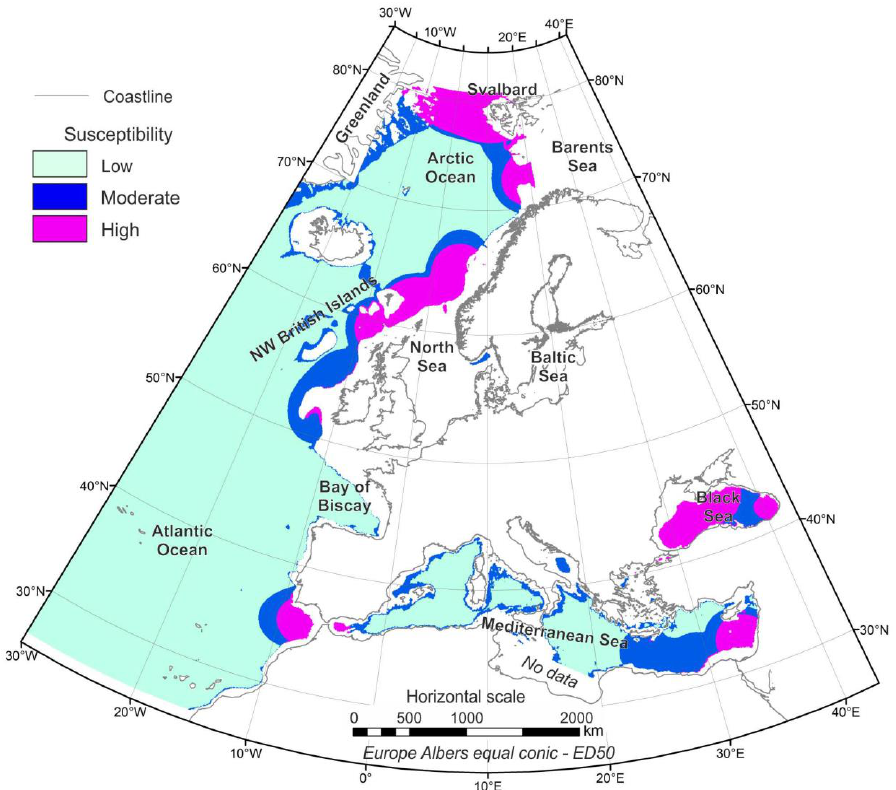
Figure 5. Susceptibility assessment of the seafloor to the presence of hydrates on the European continental margins and adjacent areas. Susceptibility values were segmented into three levels by quantiles: low from 0.009 to 0.0129, middle from 0.0129 to 0.0325 and high from 0.0325 to 1.009. The susceptibility assessment shows seven areas with high values: Svalbard, the northern Norwegian mar- gin ─ Barents Sea, the continental slope of the mid-Norwegian margin and the North Sea, the Gulf of Cádiz, the eastern Mediterranean and the Black Sea. Moderate values are lo- cated on the west Greenland continental shelf, near the northwest British Islands and on the continental slope of the western and northern Mediterranean Sea.